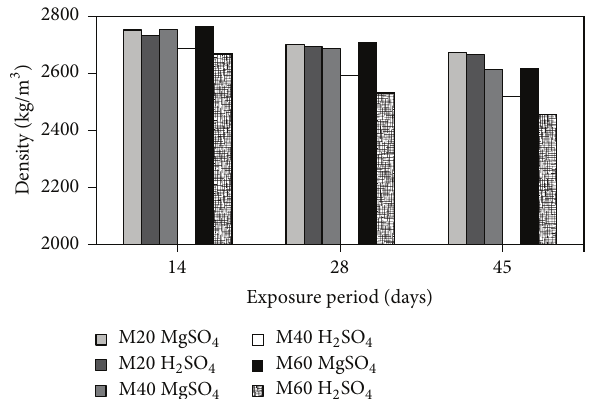
Figure 11: Density of OPC exposed to magnesium sulphate and sulphuric acid solution.